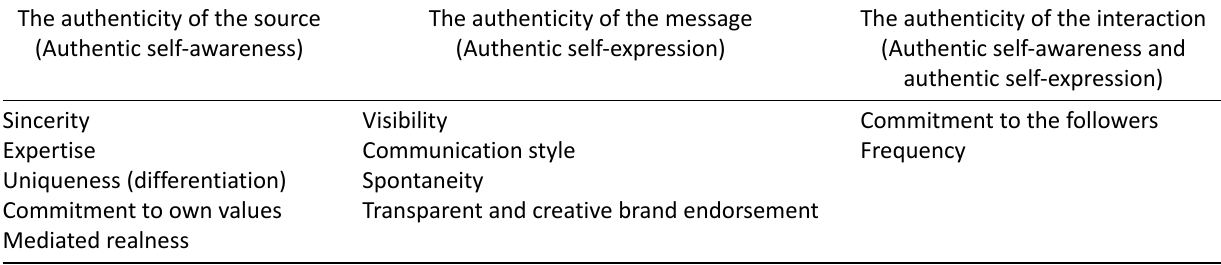
Table 2. The components of SMIs’ self‐perception of